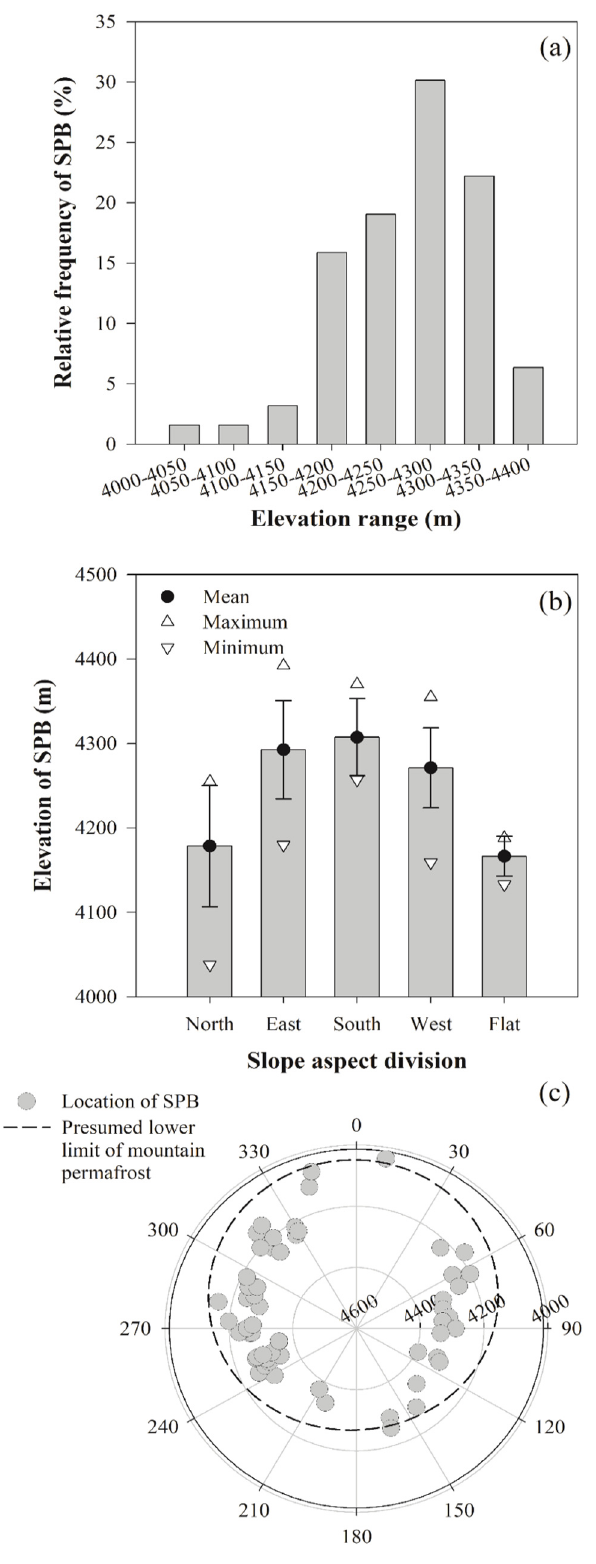
Figure 6. ( a ) The frequency of the suspected permafrost boundary (SPB) occurring in different altitude zones; ( b ) the distribution of the elevations of the SPB at different aspects (ASPs); ( c ) the distribution of the SPB in a polar coordinate system, where the scale on the horizontal axis represents the elevation (m) and the angle represents the slope ’ s orientation (degree).